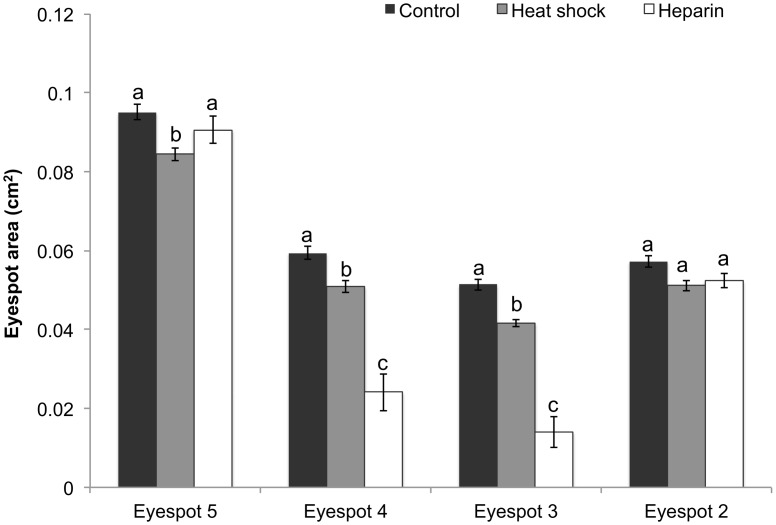
Eyespot size across all four eyespots in the different treatments.Data represent the area in cm2 with error bars representing 1 SE from the mean. The 2-way ANCOVA was performed on square-root transformed data. Results shown in Table 1. Different letters above the bars indicate significant differences within each individual eyespot.